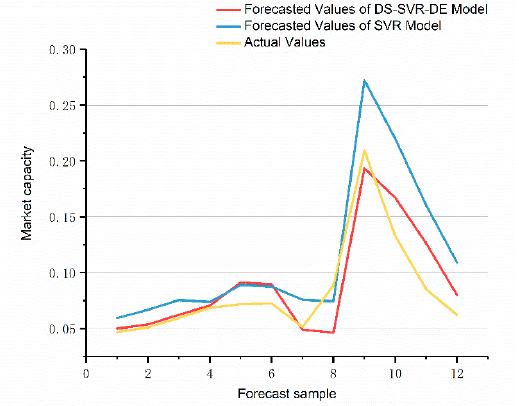
Figure 4. The long-term prediction performance of the proposed DS-SVR model and the SVR model (both adopt RFE algorithm for dimensionality reduction).